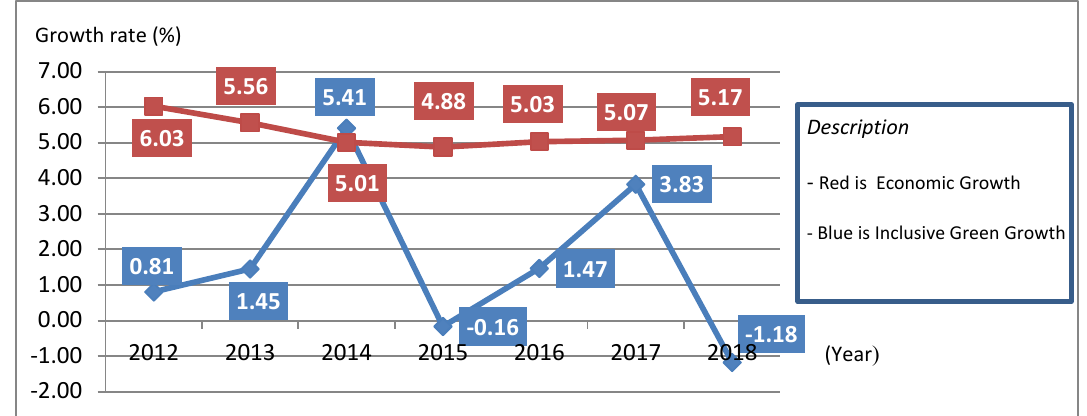
Fig. 2: Comparison of inclusive green growth with conventional economic growth in Indonesia (in percent) (CBS, 2020; NDPA, 2020; MEF,